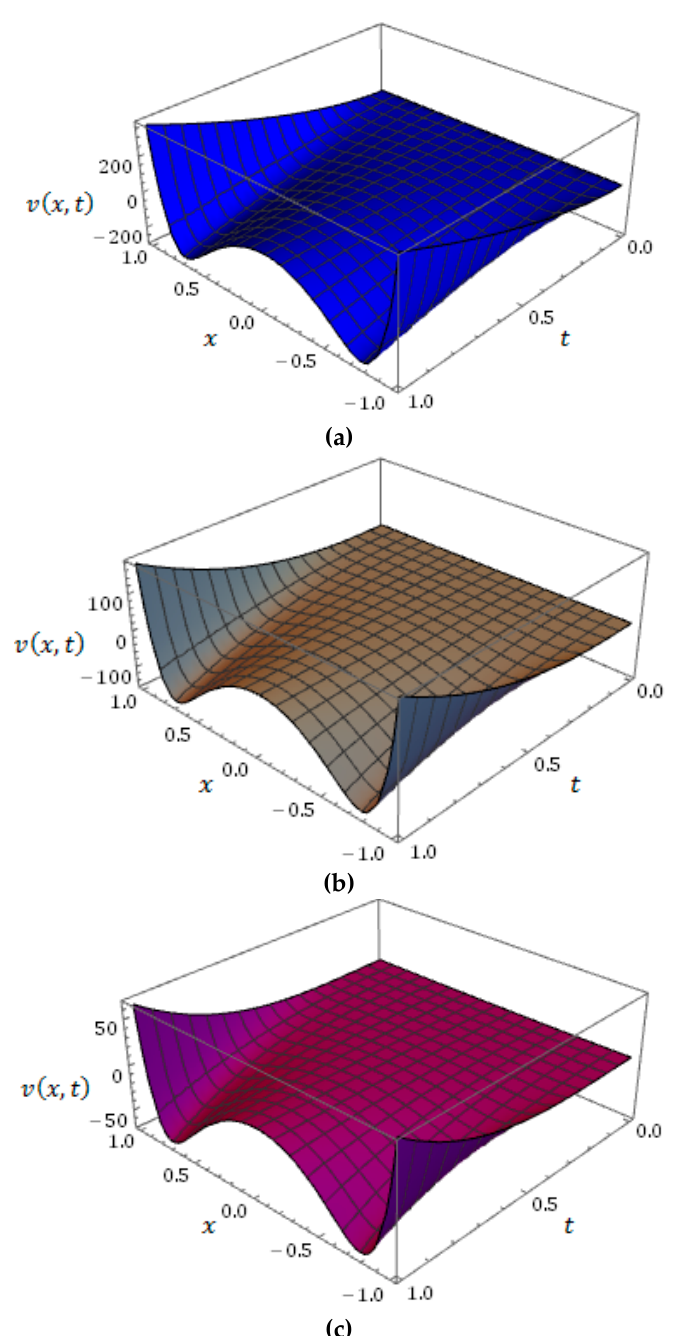
Figure 4. Surface of q -HATM solution for case ( ii ) at ( a ) µ = 0.50; ( b ) µ = 0.75; and ( c ) µ = 1 when Figure 4 . Surface of 𝑞 -HATM solution for case (𝑖𝑖) at (a) 𝜇 = 0.50 , (b) 𝜇 = 0.75 , and (c) 𝜇 = 1 (cid:125) = − 1 and n = when ℏ = −1 and 𝑛 = 1 .